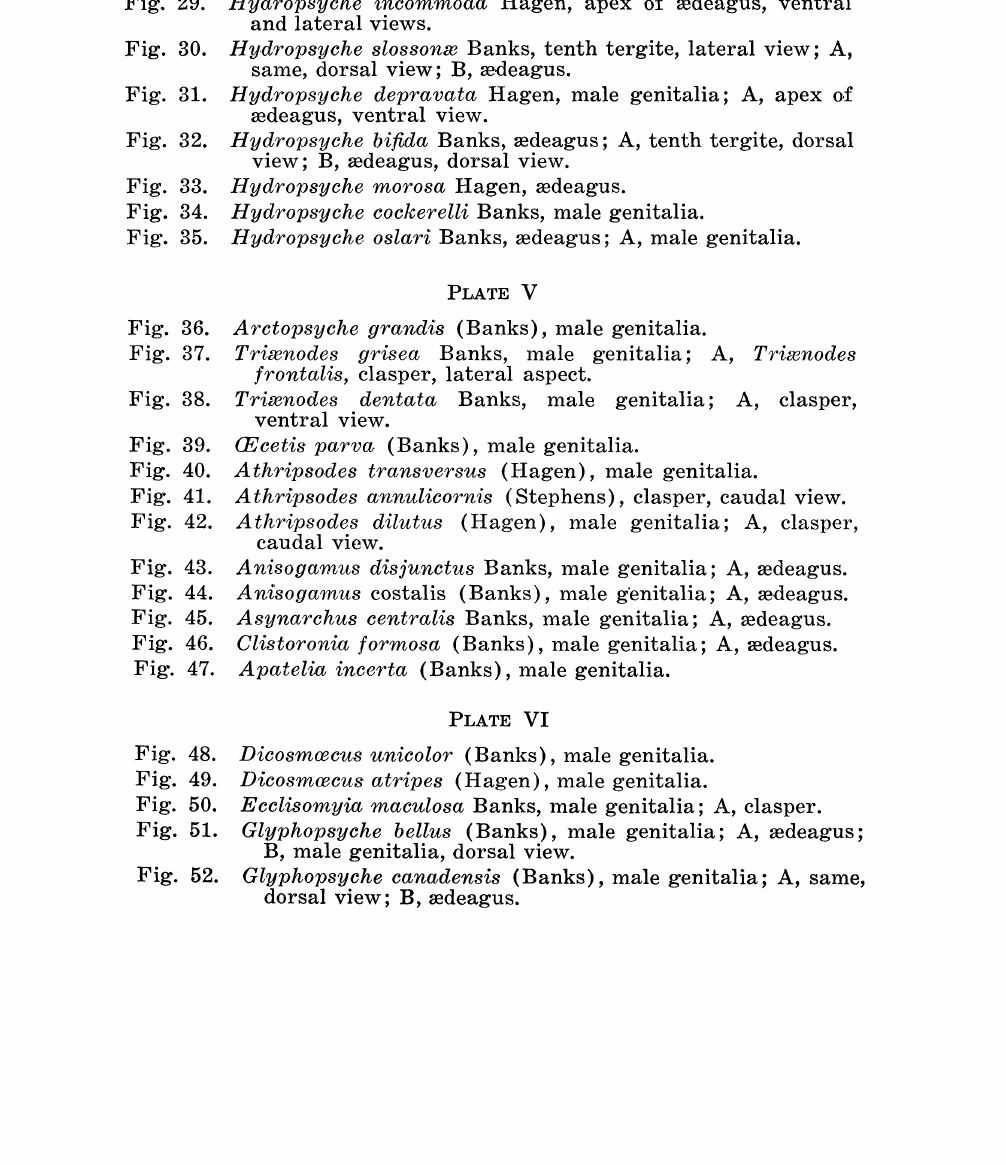
PLATE IV Hydropsyche phalerata Hagen, male genitalia; A, apex of Fig. 25. mdeagus, ventral view. Hydropsyche californica Banks, apex of mdeagus, ventral Fig. 26. and lateral views. Hydropsyche occidentalis Banks, apex of edeagus, ventral Fig. 27. and lateral views. Hydropsyche venularis Banks, mdeagus, lateral and ventral Fig. 28. views. Hydropsyche incommoda Hagen, apex of mdeagus, ventral Fig. 29. and lateral views. Hydropsyche sloss’ontv Banks, tenth tergite, lateral view; A, Fig. 30. same, dorsal view; B, sedeagus. Hydropsyche depravata Hagen, male genitalia; A, apex o.f Fig. 31. mdeagus, ventral view. Hydropsyche bifida Banks, edeagus; A, tenth tergite, dorsal Fig. 32. view; B, mdeagus, dorsal view. Hydropsyche morosa Hagen, mdeagus. Fig. 33. Hydropsyche cockerelli Banks, male genitalia. Fig. 34. Hy.dropsyche oslari Banks, edeagus; A, male genitalia. Fig. 35. PLATE V Arctopsyche grandis (Banks), male genitalia. Fig. 36. Trinodes grisea Banks, male genitalia; A, Trienodes Fig. 37. frontalis, clasper, lateral aspect. Trinodes dentata Banks, male genitalia; A, clasper, Fig. 38. ventral view. Fig. 39. G,cetis. parva (Banks), male genitalia. A thripso.des transversus (Hagen), male genitalia. Fig. 4O. A thripsodes annulicornis (Stephens), clasper, caudal view. Fig. 41. A thripsodes dilutus (Hagen), male genitalia; A, clasper, Fig. 42. caudal view. Anisogamus disjunctus Banks, male genitalia; A, mdeagus. Fig. 43. Anisogamus costalis (Banks), male genitalia; A, m.deagus. Fig. 44. A synarchus centralis Banks, male genitalia; A, edeagus. Fig. 45. Clistoronia formosa (Banks), male genitalia; A, mdeagus. Fig. 46. Fig. 47. Apatelia incerta (Banks), male genitalia. PLATE VI Fig. 48. Dicosmacus unicolor (Banks), male genitalia. Fig. 49. Dicosmcus atripes (Hagen), male genitalia. Fig. 5O. Ecclisomyia maculosa Banks, male genitalia; A, clasper. Glyphopsyche bellus (Banks), male genitalia; A, mdeagus; Fig. 51. B, male genitalia, dorsal view. Fig. 52. Glyphopsyche canadensis (Banks), male genitalia; A, same, dorsal view; B,